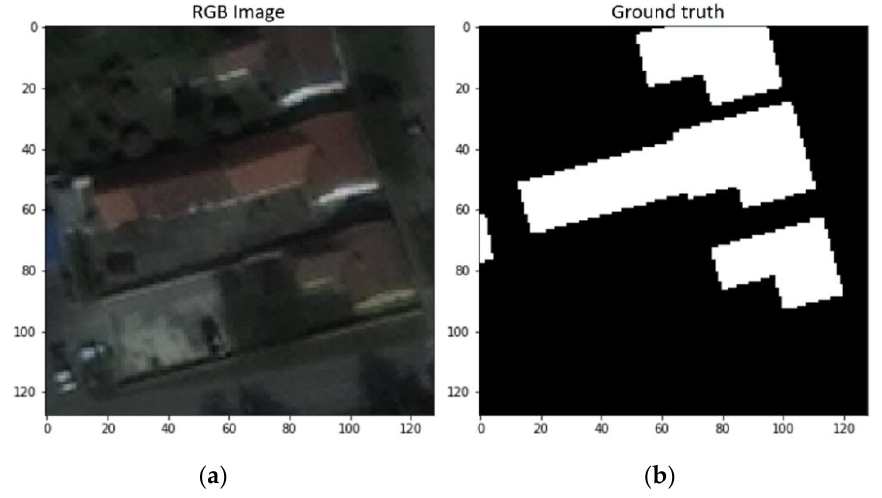
Table 1. Number of images used for training, test and prediction, and total number of objects. Figure 10. An example of a pair of input data used for training: ( a ) Subotica; ( b ) Zrenjanin.